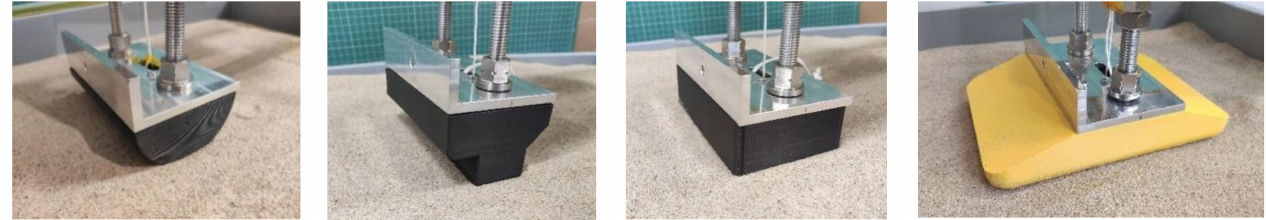
Figure 12. From left: configuration #1 with a cylindrical 3D-printed foot in contact with quartz sand; configuration #2 actuating leg with a flat surface contact area same as config #1; configuration #3 with a flat surface contact area based on a width equivalent to the diameter of the round foot; configuration #4 with a flat foot with a contact area 4.8 times greater than contact area from the configuration #1 and